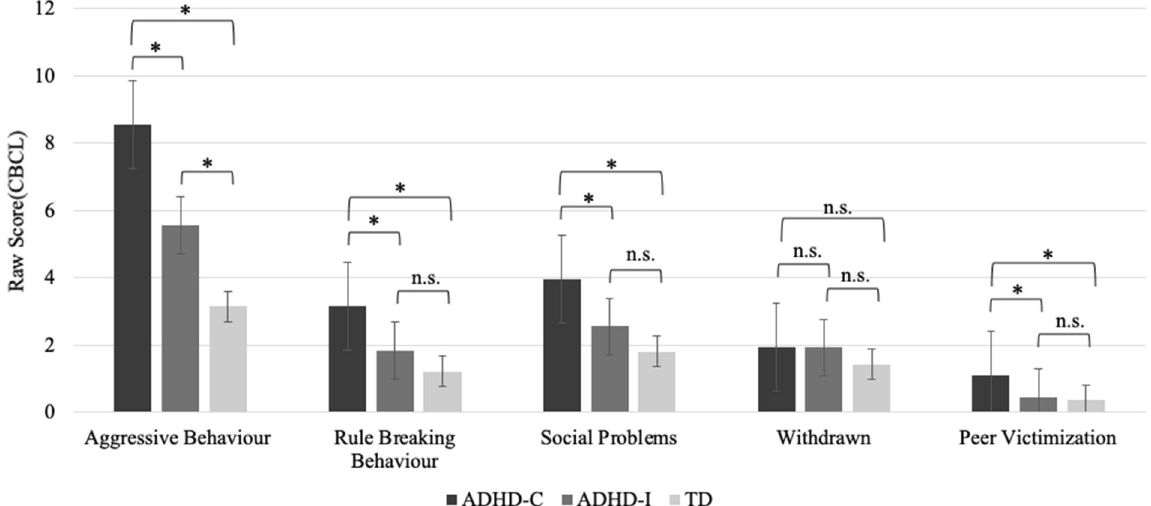
Figure 1. Problem behaviours and peer victimization in diagnostic groups. CBCL subscale scores for children from the ADHD-C, ADHD-I, and TD groups. Children from the ADHD-C group had significantly higher aggressive behaviour, rule breaking behaviour, social problems, and peer victimization scores compared to the TD group. The ADHD-C group also had significantly higher aggressive behaviour, rule breaking behaviour, social problems and peer victimization scores compared to the ADHD-I group. Children and adolescents in the ADHD-I group had significantly higher aggressive behaviour scores than the TD group. None of the groups significantly differed on the withdrawn scores. Scores represent the estimated marginal means, adjusted for age, sex, study site, and SES. P values are Bonferroni corrected (pairwise) for multiple comparisons. Error bars reflect standard error. * p <